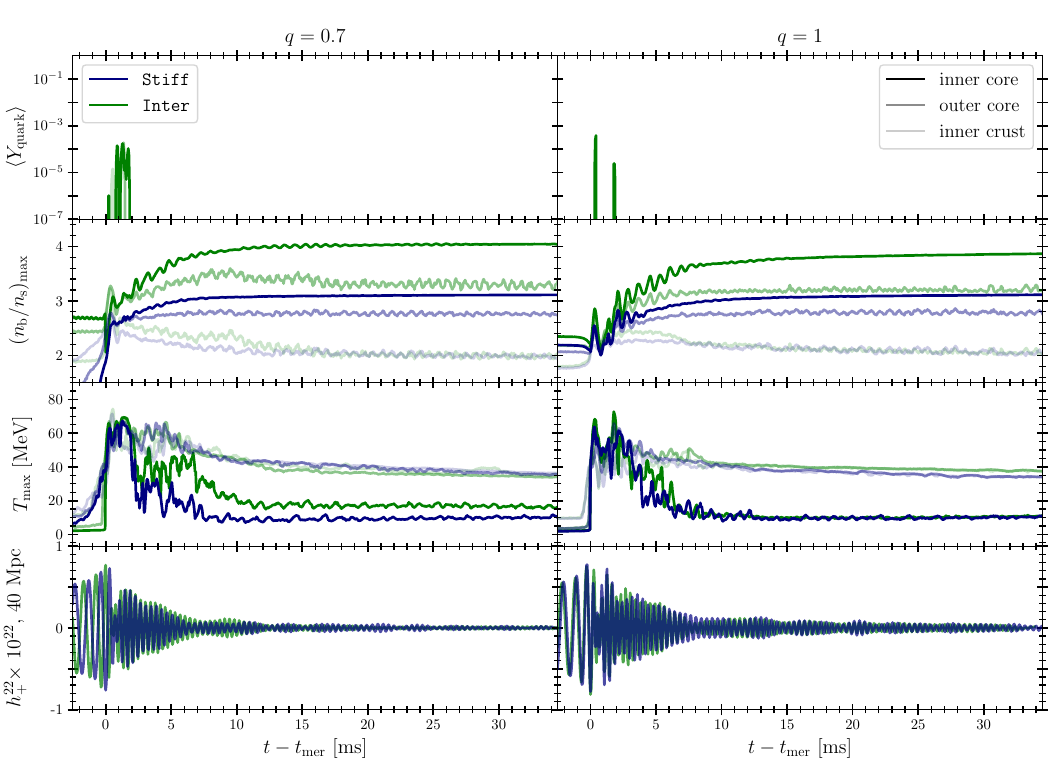
Figure 7: The results of the Stiff and Inter medium resolution runs for both investigated mass ratios. In neither do we observe a collapse throughout the whole ∼ 35 ms of the post-merger evolution.